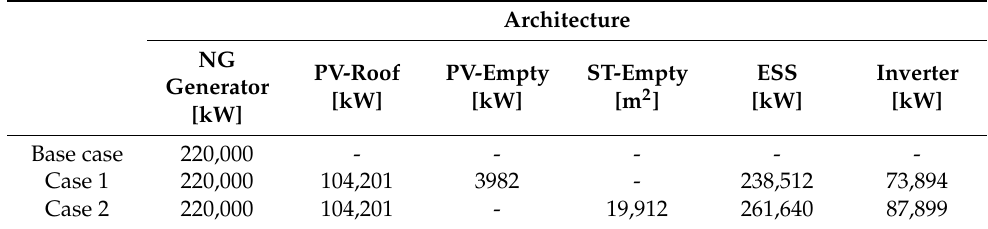
Table 2. Comparison of system capacity in each case.